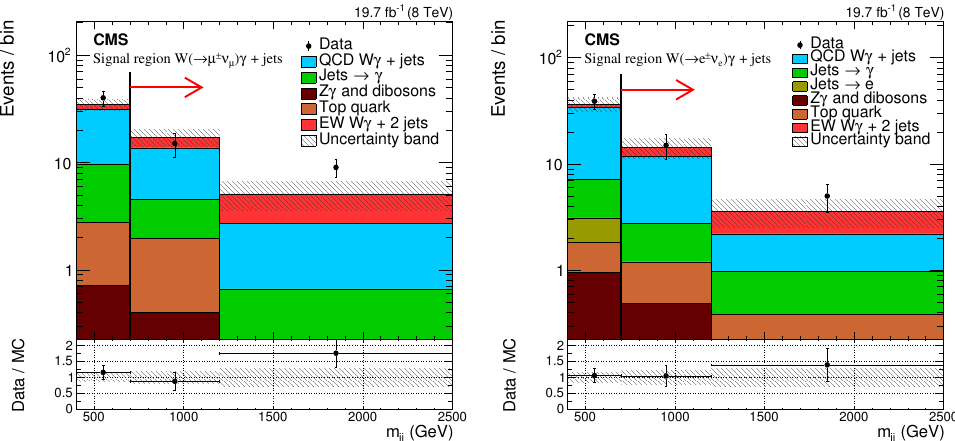
Figure 3 . The m jj distribution in the muon (left) and electron (right) channels, in which the signal region lies above 700 GeV, indicated by the horizontal thick arrows. Backgrounds from jets misidenti(cid:12)ed as photons (Jets ! (cid:13) ) and jets misidenti(cid:12)ed as electrons (Jets ! e) are estimated from data as described in the text. The diboson contribution includes WV(+ (cid:13) ) and Z (cid:13) (+jets) processes. The top quark contribution includes both the tt (cid:13) and single top quark processes. The signal contri- bution is shown on top of the backgrounds. The last bin includes the over(cid:13)ow events. The shaded area represents the total uncertainty in the simulation, including statistical and systematic